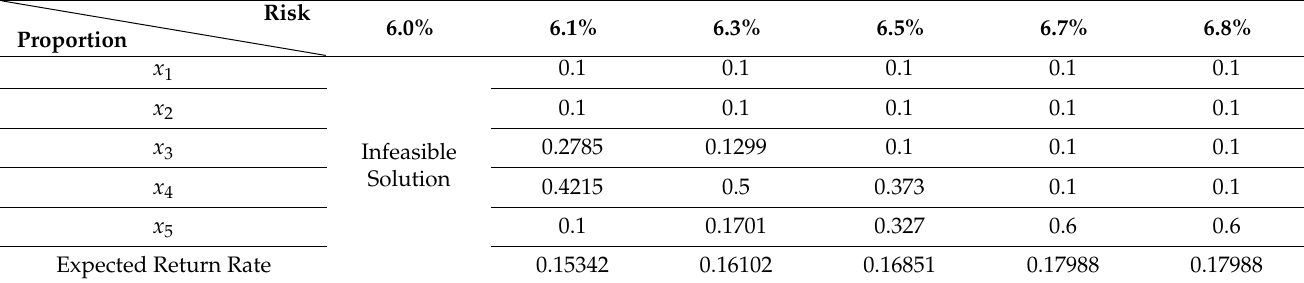
Table 10. The efficient portfolio with s = 4 in a guaranteed return rate (cid:101) p 1